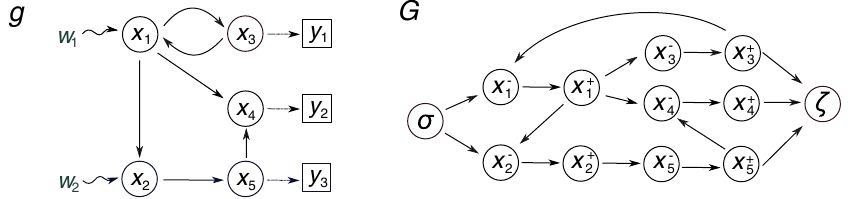
FIG. 4. An example for the structural invertibility algorithm counting the number of node-disjoint paths connecting the input node set S ¼ f x 1 ; x 2 g with the output node set Z ¼ f x 3 ; x 4 ; x 5 g . The influence graph g is transformed into the graph G by replicating each of the state nodes x 1 ; … ; x 5 to x þ 1 ; … ; x þ 5 and x − 1 ; … ; x − 5 , thereby separating the ingoing and outgoing edges. A family of node-disjoint paths in g corresponds to a family of edge-disjoint paths in G . Then, an additional source node σ is connected to the inputs, and an additional sink node ζ to the outputs and edge weights of 1 are assigned to G . The maximum flow from σ to ζ corresponds to the number of node- disjoint paths from S to Z in g